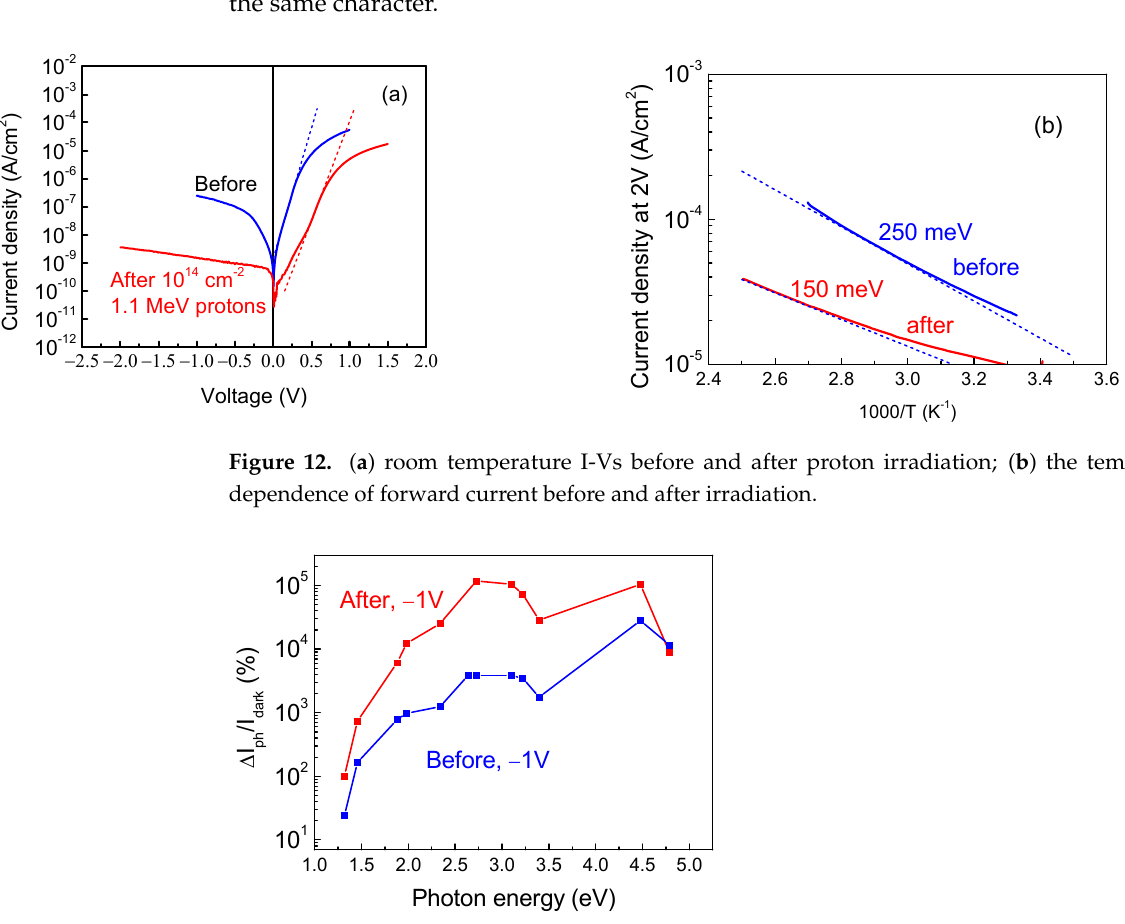
Figure 14. ( a ) C ‐ f characteristics before and after irradiation; ( b ) concentration profiles before and after irradiation.